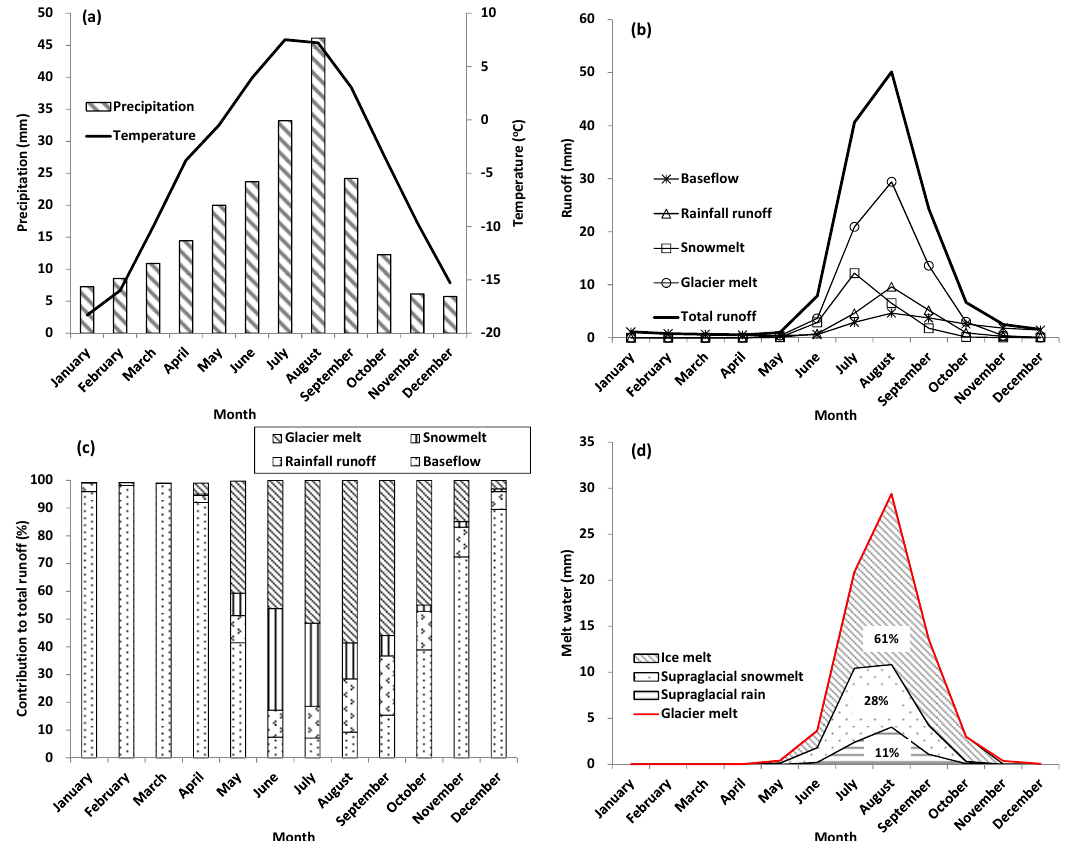
Figure 6. Monthly average temperature and precipitation ( a ); separated annual hydrographs for total runoff and the four major components of river flows from 1968 to 2007 ( b ); histograms showing the monthly contributions of the four components of flows in terms of the percentage of contributions to the total runoff ( c ); area diagrams for monthly ice melt, supraglacial snow melt and rain, which form the glacier melt ( d ).